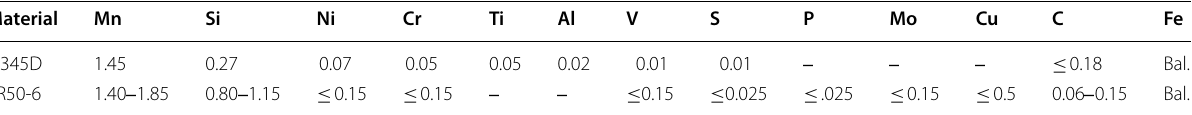
Table 1 Nominal chemical compositions of base metal and filler metal (wt %)